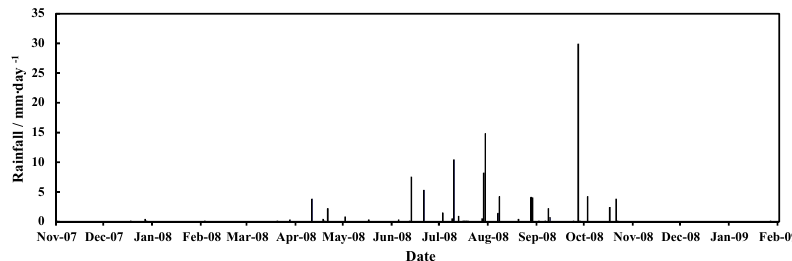
Figure 4. Daily rainfall at the Yingke site from November 2007 to January 2009.